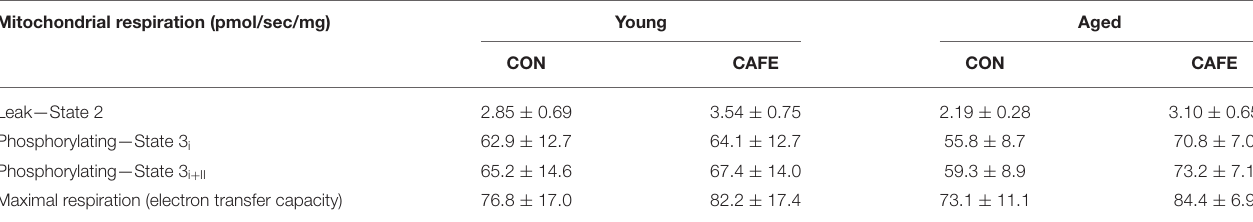
TABLE 3 | Mitochondrial respiratory capacity in gastrocnemius permeabilized myofibers in response to experimental cafeteria diet. Determined following 12-week exposure to either a control (CON) or high-fat calorie dense diet (CAFE). Mitochondrial respiration (pmol/sec/mg) Young Aged CON CAFE CON